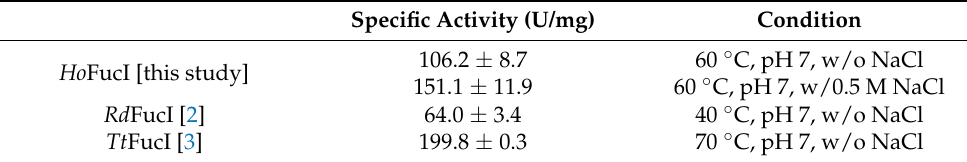
Table 3. Comparison of the specific activities of L -FucIs against L -fuculose